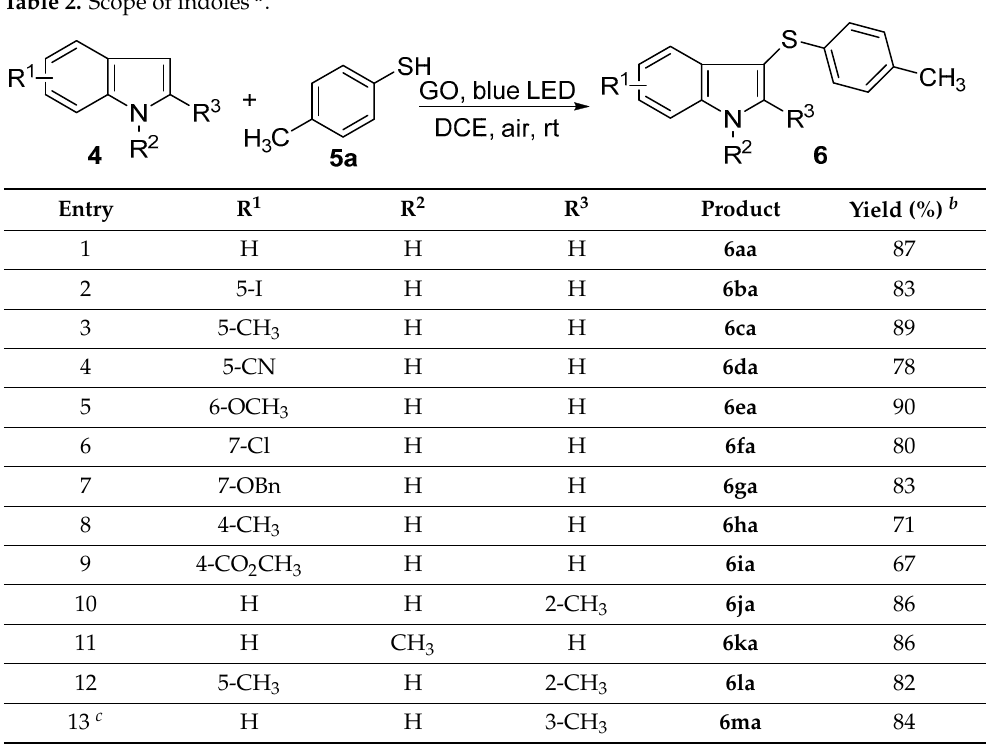
Table 2. Scope of indoles a .